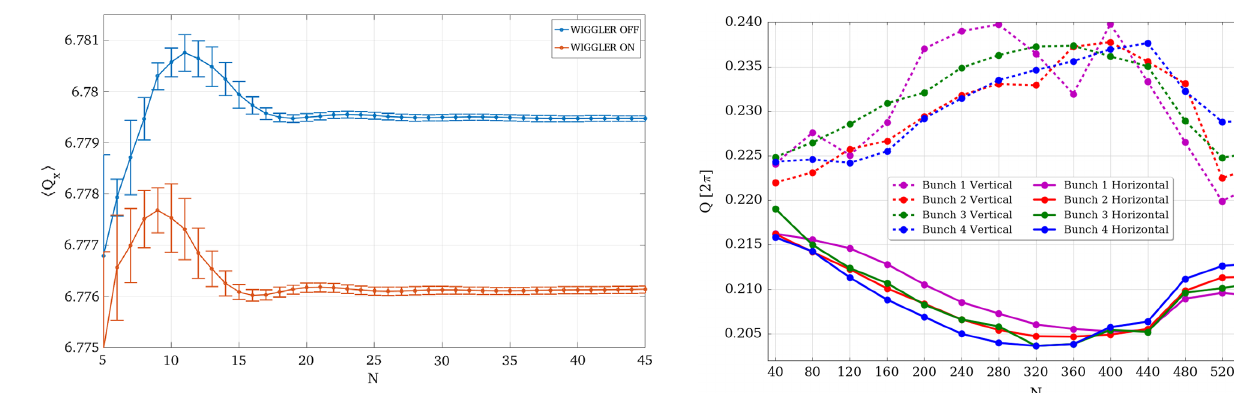
FIG. 20. Instantaneous betatron tune measurements with the mixed BPM method, during the injection process at the PS. The estimation of the horizontal tunes is shown in thick lines and of the vertical tunes in dashed lines. The analysis is performed for four bunches (bunch 1 in magenta, bunch 2 in red, bunch 3 in green, and bunch 4 in blue) by using a sliding window of 40